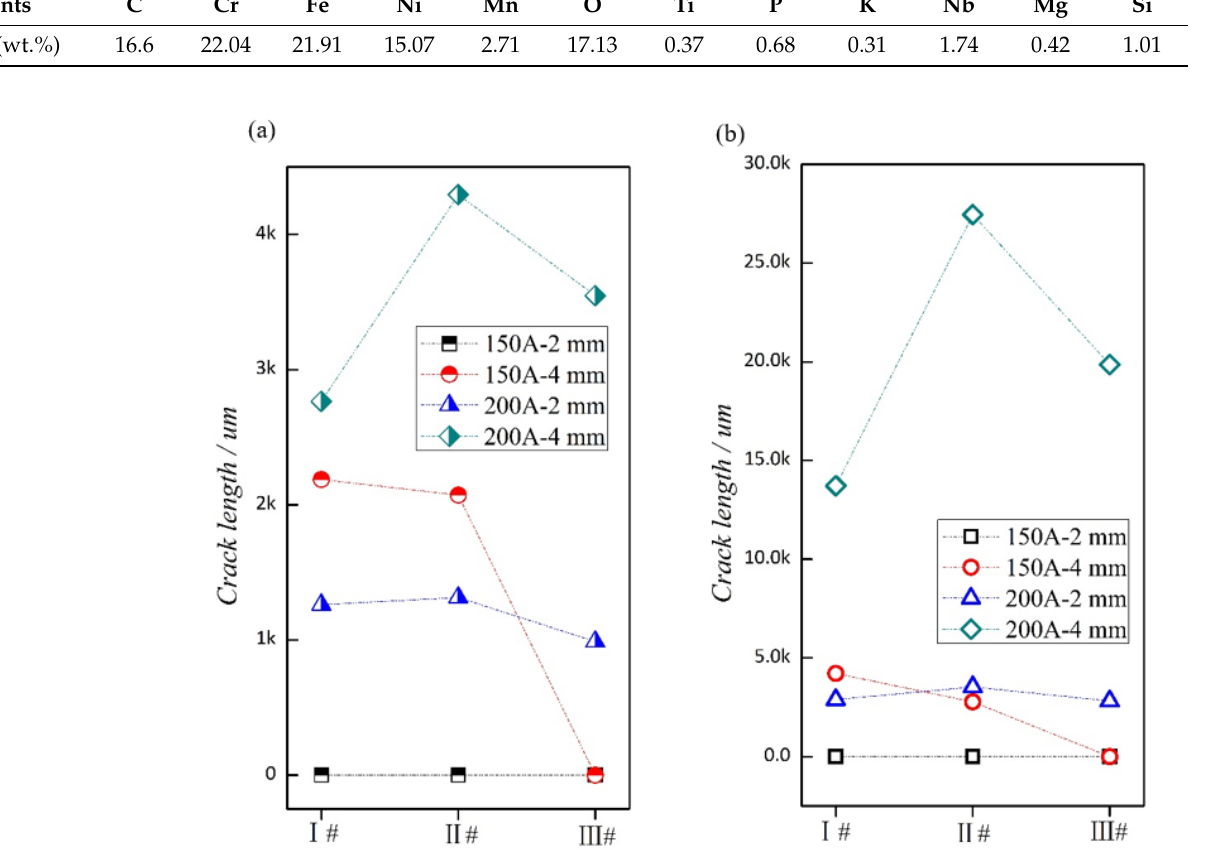
Figure 7. DDC crack statistics: ( a ) the maximum crack length and ( b ) the total length of the